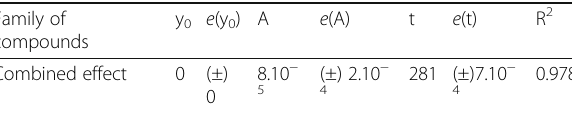
Table 7 Fitting correlation parameters found for the combined effect of the predominant compounds in the rum filter Family of y 0 e (y 0 ) A e (A) t e (t) R 2 compounds Combined effect 0 (±)